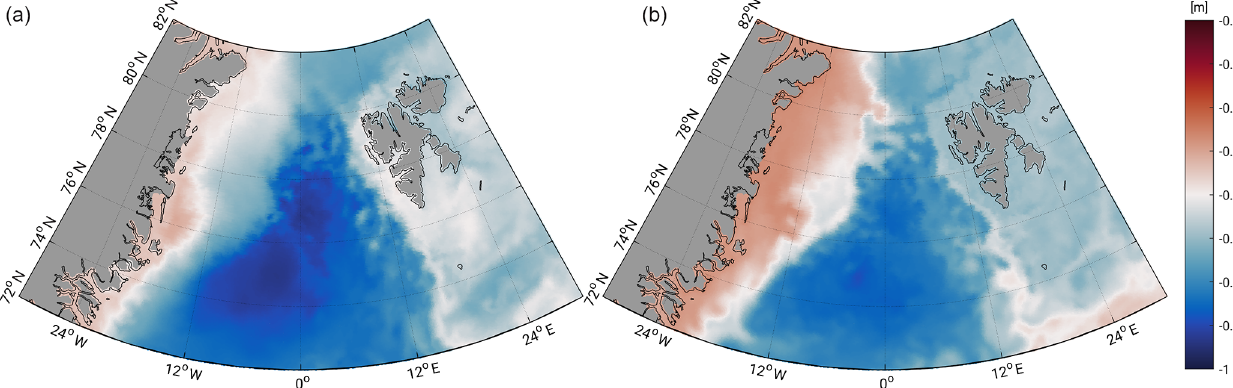
Figure 3. Exemplary differential water heights in March 2004 (a) and July 2006 (b) simulated by FESOM. Note the different scaling of color bars in comparison to Fig.